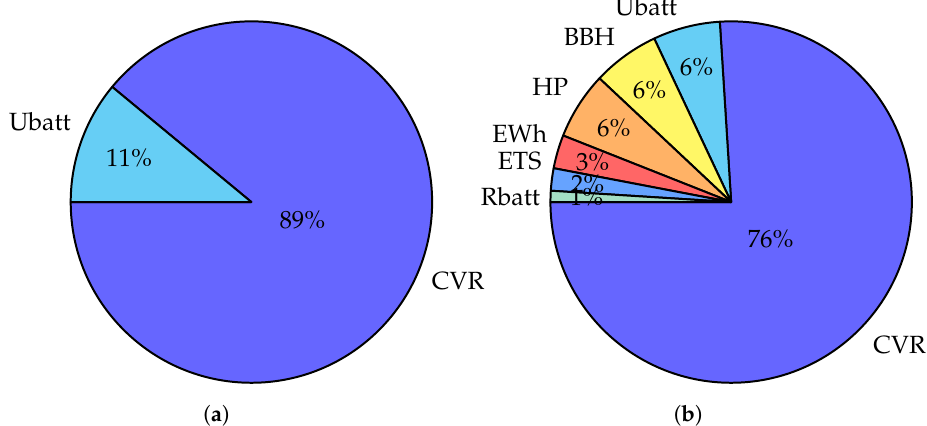
Figure 8. ( a ) Contributions of EERs for peak load shaving in September 2021; ( b ) contributions of EERs for peak load shaving in November 2021.